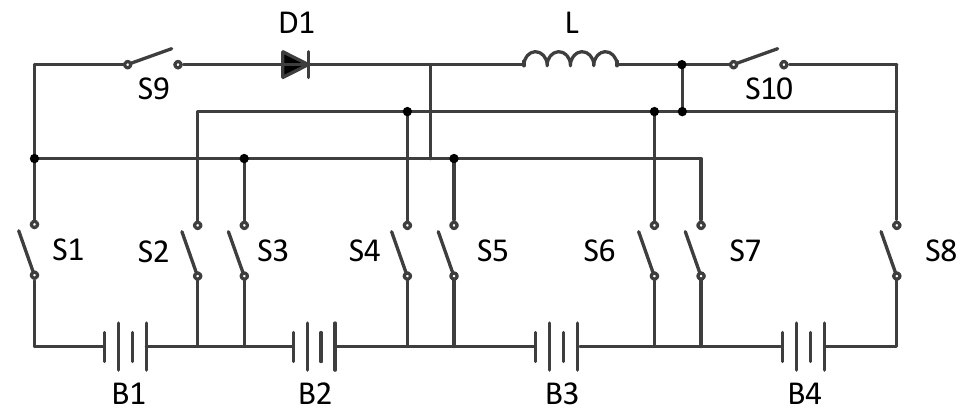
Figure 4. Balance principle of one inductor in a battery stack.